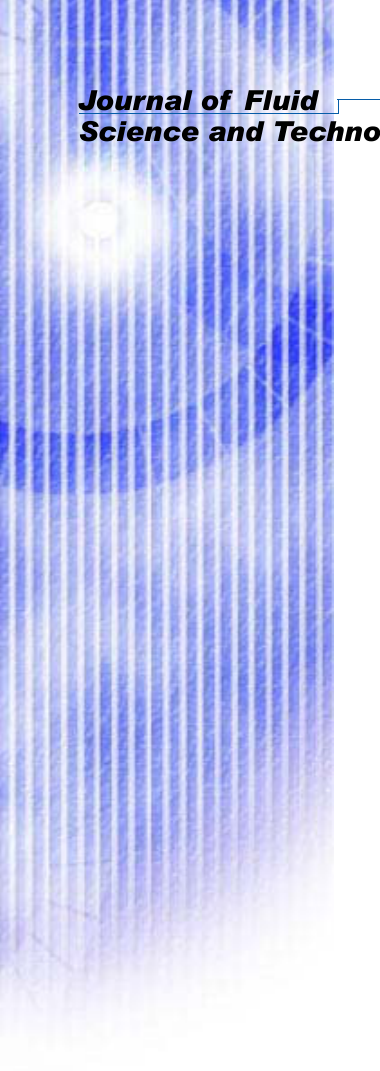
Fig. 8 Comparison of Fig. 9 Comparison of